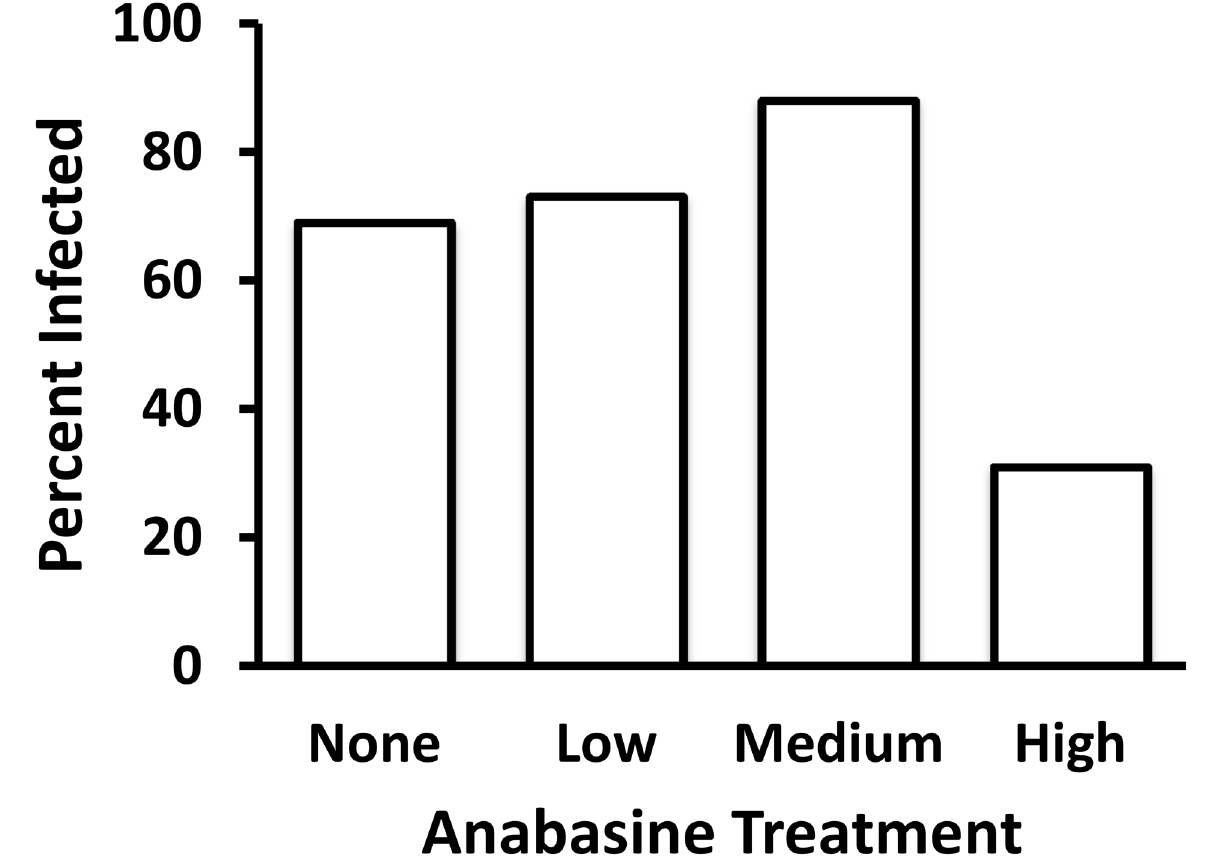
Fig 1. Effects of anabasine treatment on probability of infection at time of death. Anabasine treatment significantly affected the mean probability of bees having detectable C . bombi at time of death (P = 0.0256).